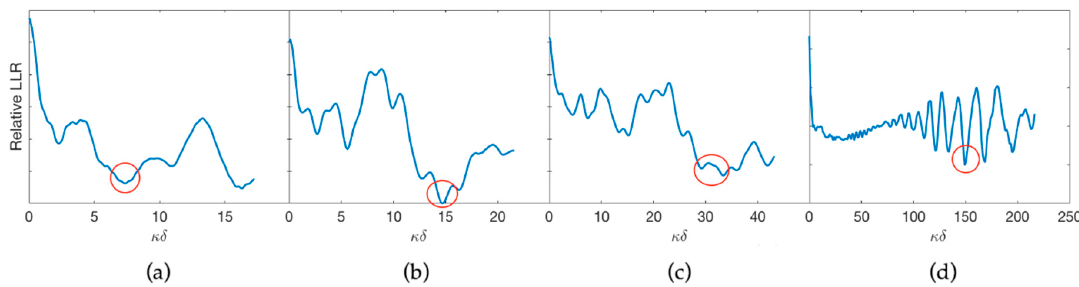
Figure 10. Stand-off given in number of wavelengths vs. relative loss of lateral resolution for different frequencies. The value of κδ for the optimum stand-off (red circle) is directly proportional to the frequency. ( a ) f = 0.2225 MHz; ( b ) f = 0.445 MHz; ( c ) f = 0.890 MHz; ( d ) f = 4.45 MHz.